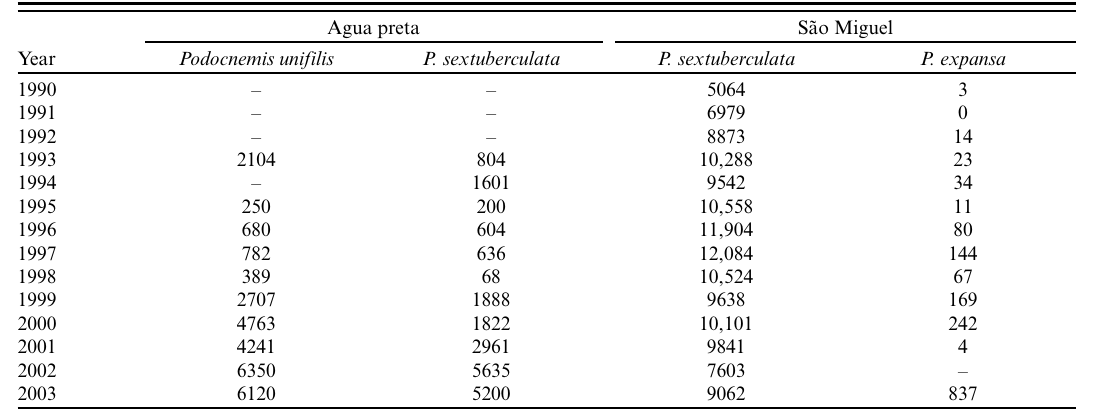
Table 1 . Number of nests counted by local residents in two communities between 1990 and 2003 (quality of official data is limited by variation in counting effort between different seasons).